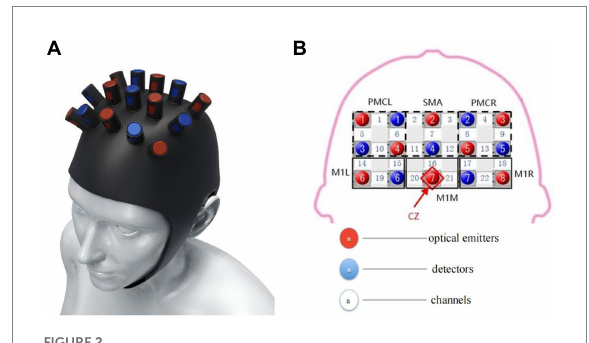
FIGURE 2 (A) Fiber cap positioning in the EEG 10/20 system. (B) Channel coverage in each ROI area.